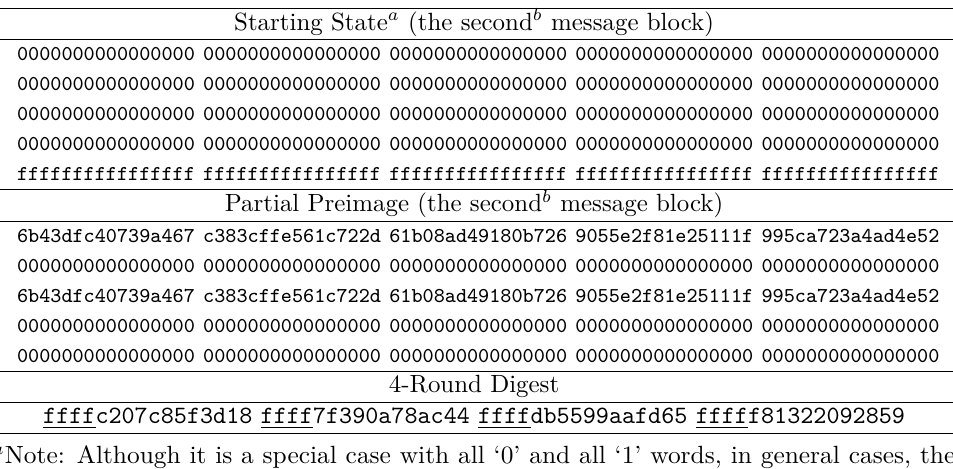
Table 12: One instance matching 64-bit digest (in big-endian